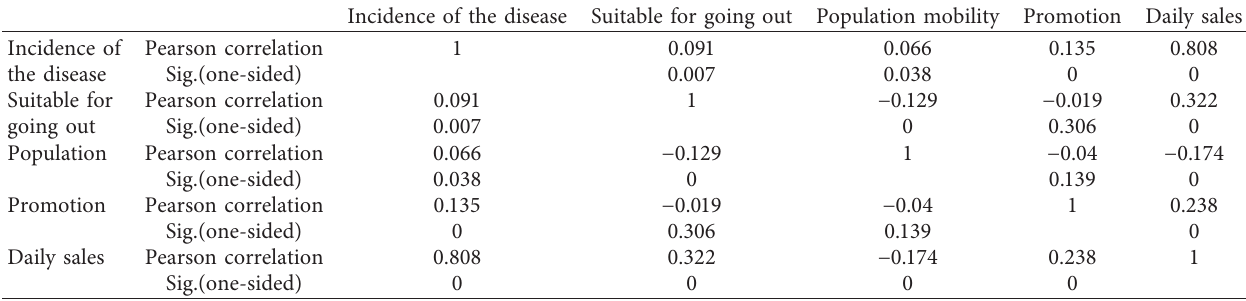
Table 7: Correlation analysis.